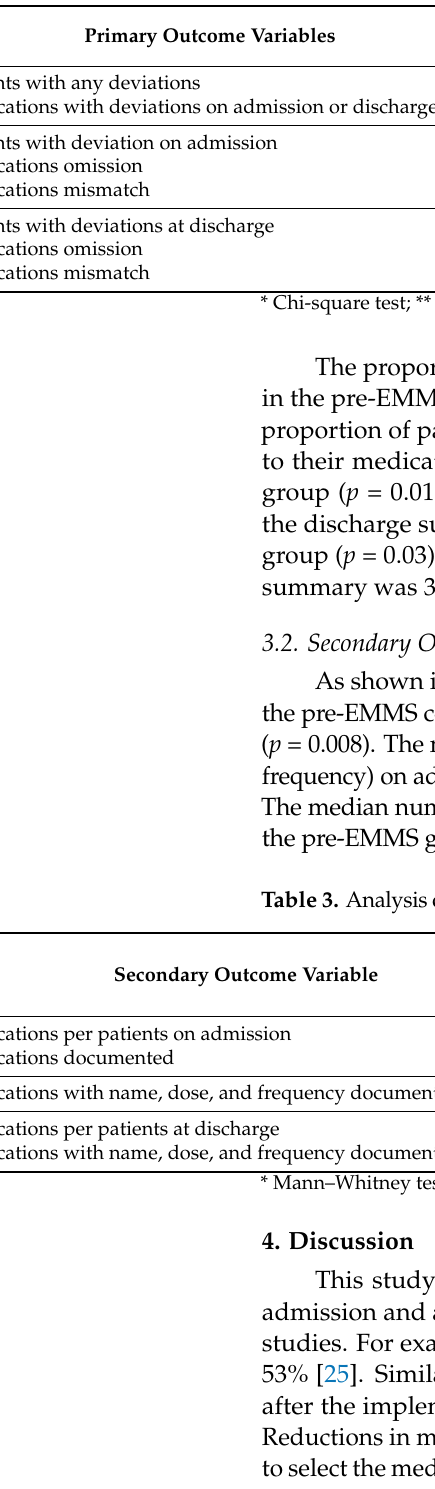
Table 2. Analysis of patients with a medication deviation before and after the implementation of EMMS.